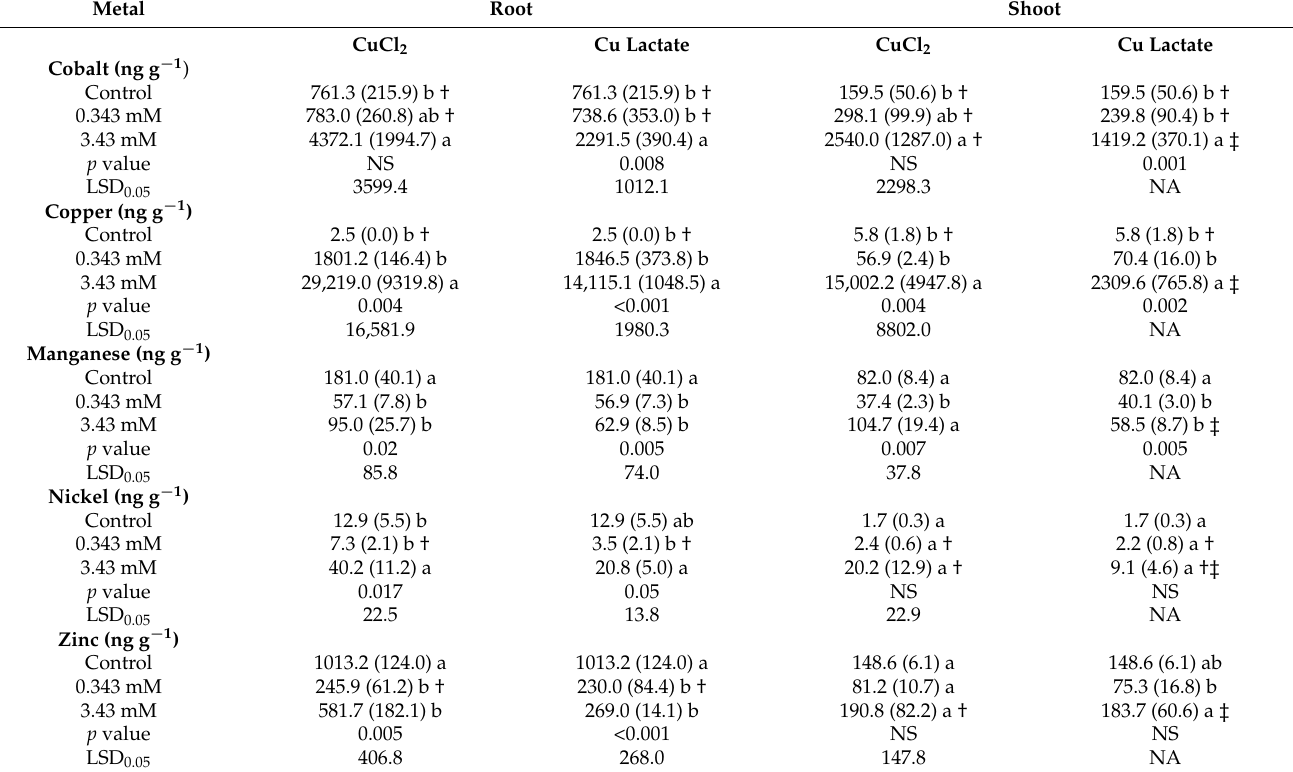
Table 6. Mean concentration of Co, Cu, Mn, Ni and Zn in the root and shoot tissues of wheat grown with copper chloride or copper lactate. Control samples did not receive any copper supplementation. Different letters indicate a statistically significant difference between treatment concentrations and control ( p < 0.05; Fisher’s LSD Test). The “†” symbol indicates that the mean was derived from one or more replicates with metal concentrations below the instrument detection limit (DL) and were substituted with values equal to the DL/2. No significant differences in tissue metal concentrations were detected between copper chloride and copper lactate of any concentration for any metal analyzed ( p < 0.05; simple t -test). Standard error is denoted in parenthesis; n = 5 (“‡” indicates n = 4). NS: not significant; NA: not